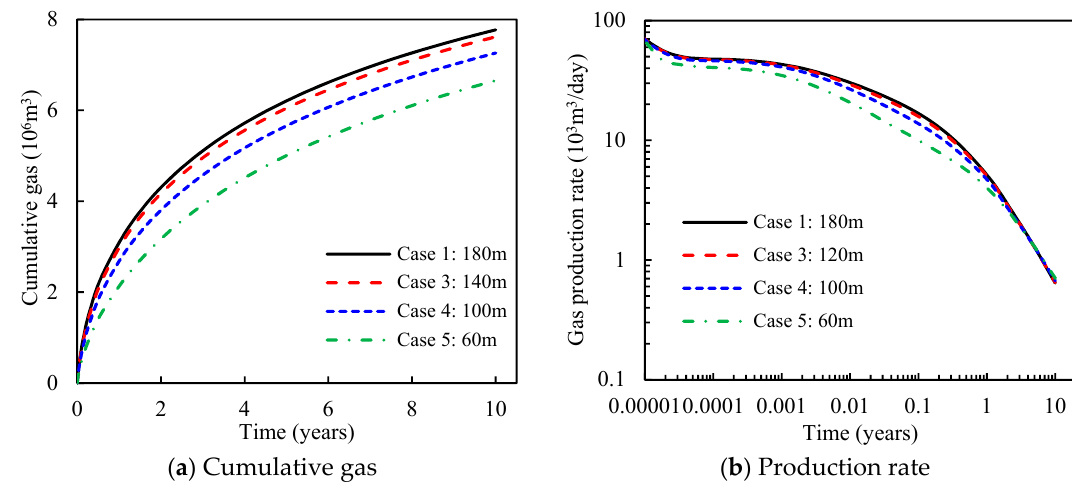
Figure 17. Comparison of σ xx distribution between different cases after 10 years, MPa. The profiles are shown in the top, middle and bottom layers, and the length in the z -direction is shown as 6.67 times the real size.